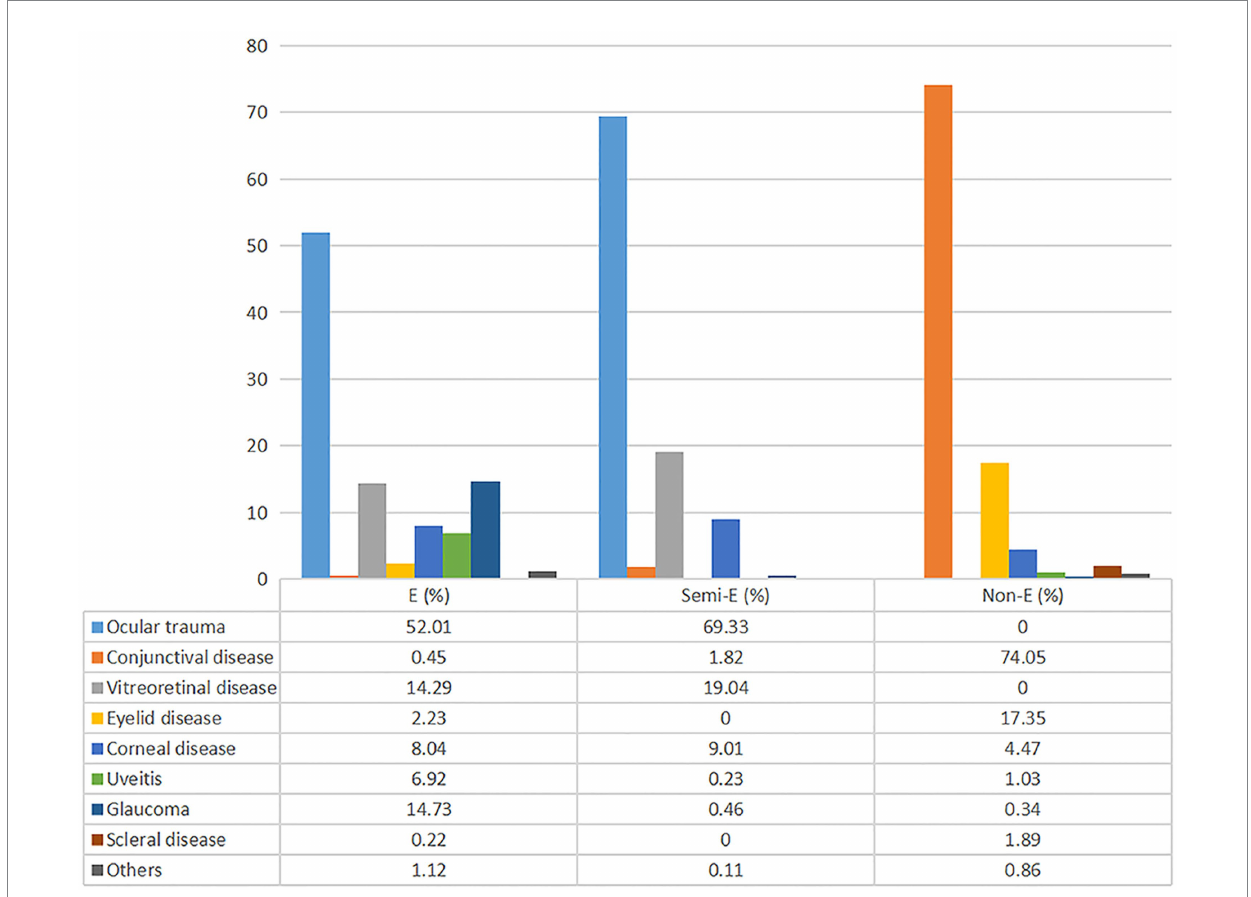
FIGURE 1 Disease spectrum of eye-related emergency visits based on different triage grades. E, emergency; Semi-E, semi-emergency; Non-E,